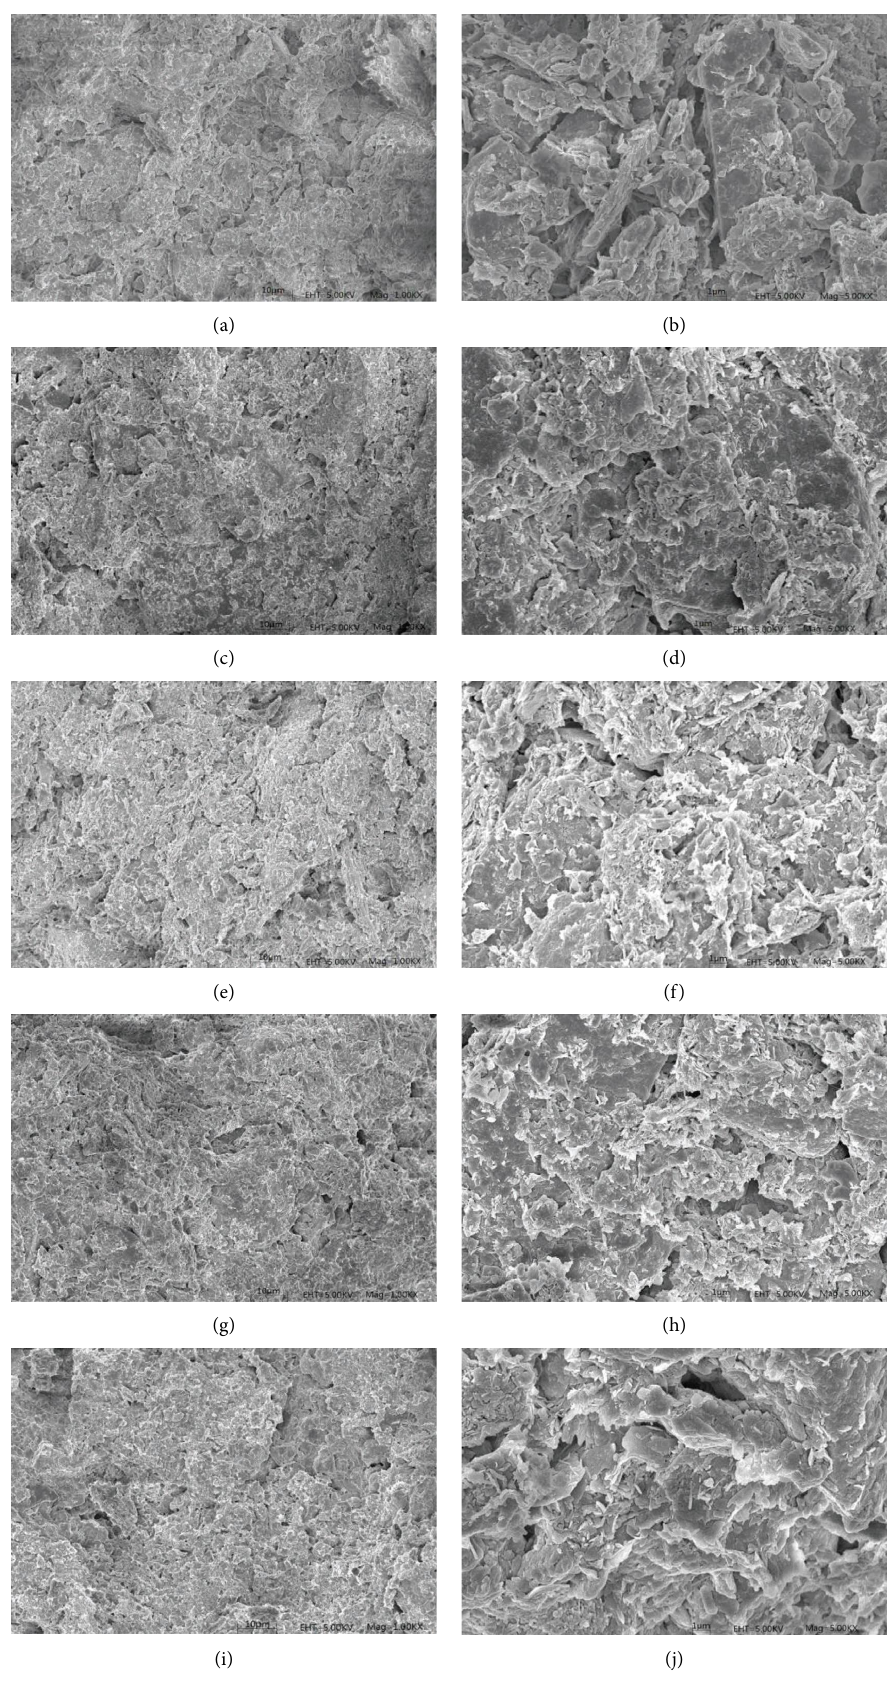
Figure 12: SEM images of W - D cycle path b . (a) n � 0 (1000X); (b) n � 0 (5000X); (c) n � 3 (1000X); (d) n � 3 (5000X); (e) n � 6 (1000X); (f) n � 6 (5000X); (g) n � 9 (1000X); (h) n � 9 (5000X); (i) n � 12 (1000X); (j) n � 12 (5000 X